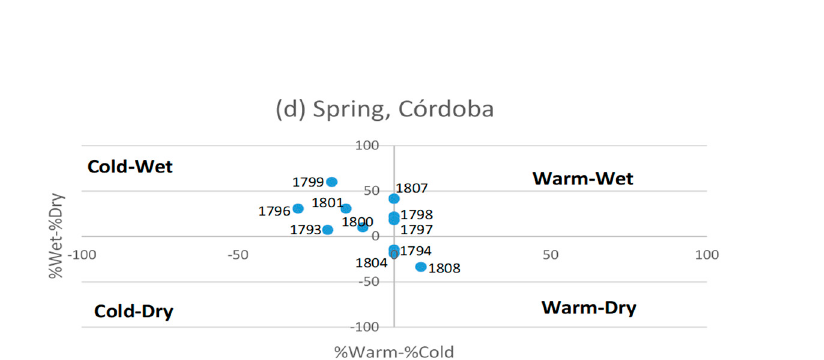
Figure 3. ( a ) Number of spring records in Córdoba from 1792 to 1808. ( b ) Percentage of records indicating cold (blue) and warm (red) conditions. ( c ) Percentage of records indicating dry and wet conditions. ( d ) Characterization of the combined temperature and rainfall conditions in Córdoba from 1792 to 1808. Years are indicated.